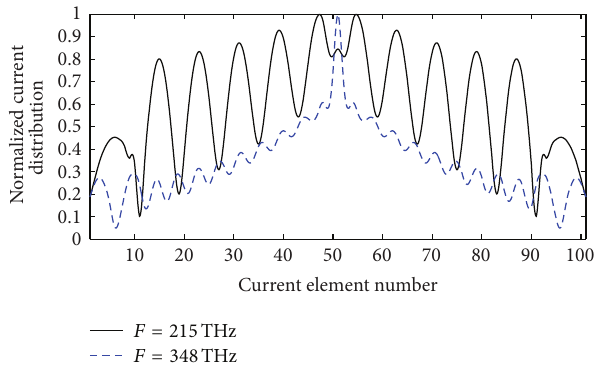
Figure 8: Discretization of simulated nanocircuit. Parameters are = 𝑎 = 10 nm, 𝑑 = 4 0nm, 𝑁 ℎ = 210 nm, 𝐿 = 1200 nm, 𝑎 𝐿 ℎ = 40 , Δ𝐿 = 30 nm, Δ𝐿 = 21 nm, and 𝑁 = 102 . 𝑁 𝐿 𝐿 ℎ